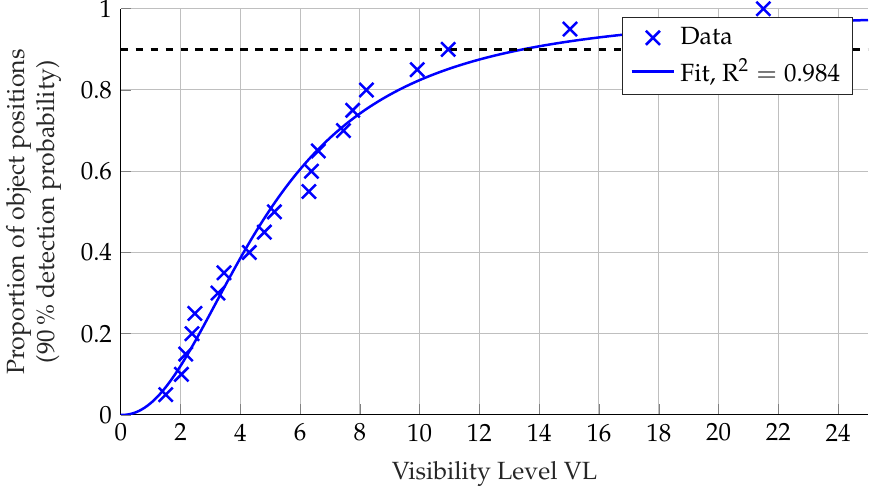
Figure 12. Relationship between the Visibility Level VL and the proportion of object positions in the light tunnel at which the gray card is reliably detected; to reliably detect the gray card at 90% of the object positions, a Visibility Level of 13.35 is